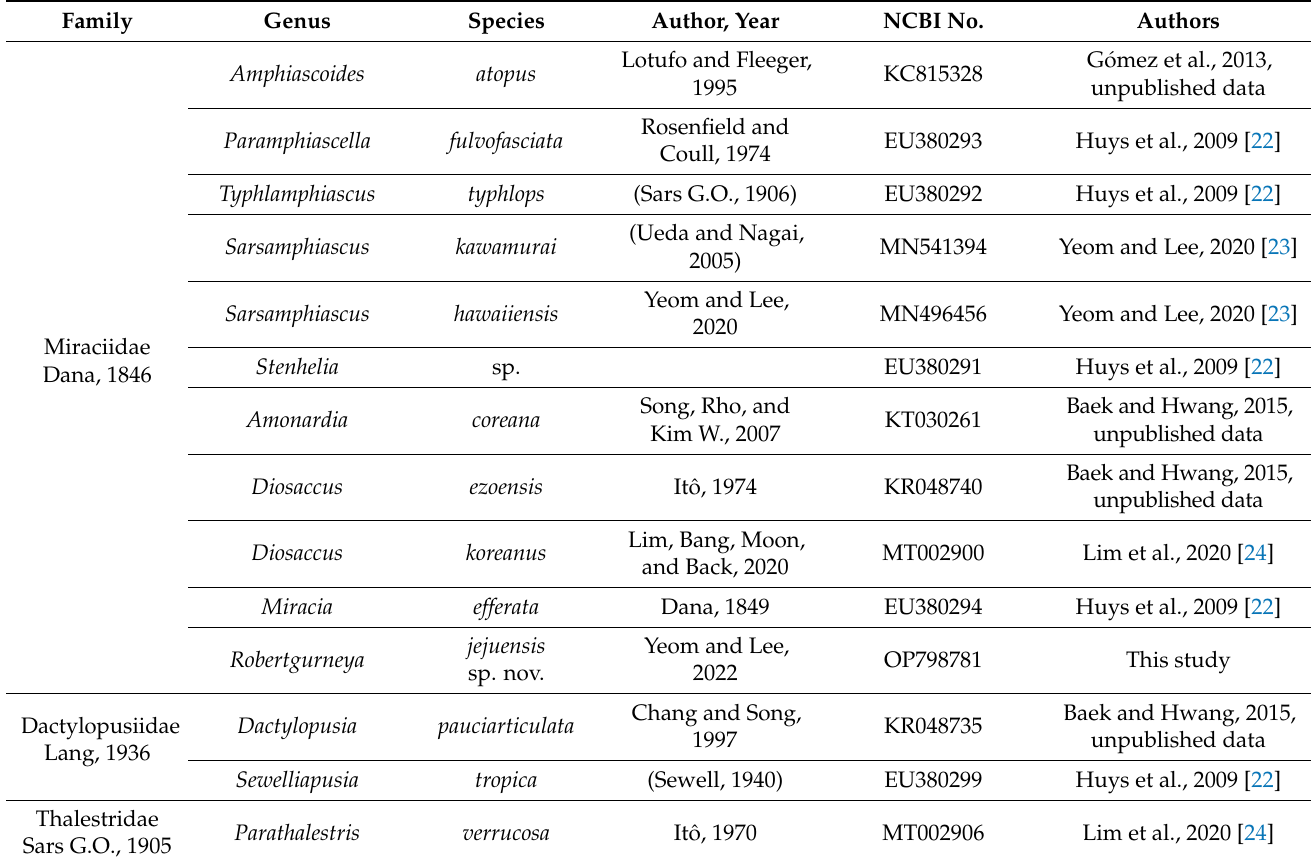
Table 1. GenBank numbers of 18S rRNA sequences used in phylogenetic analyses in this